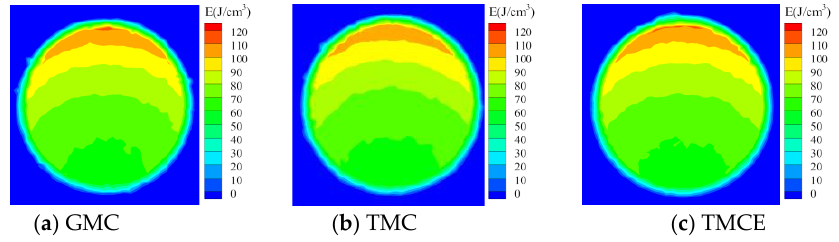
Figure 7. Photon deposition (J/cm 3 ) in the central cross-section of the vascular region.